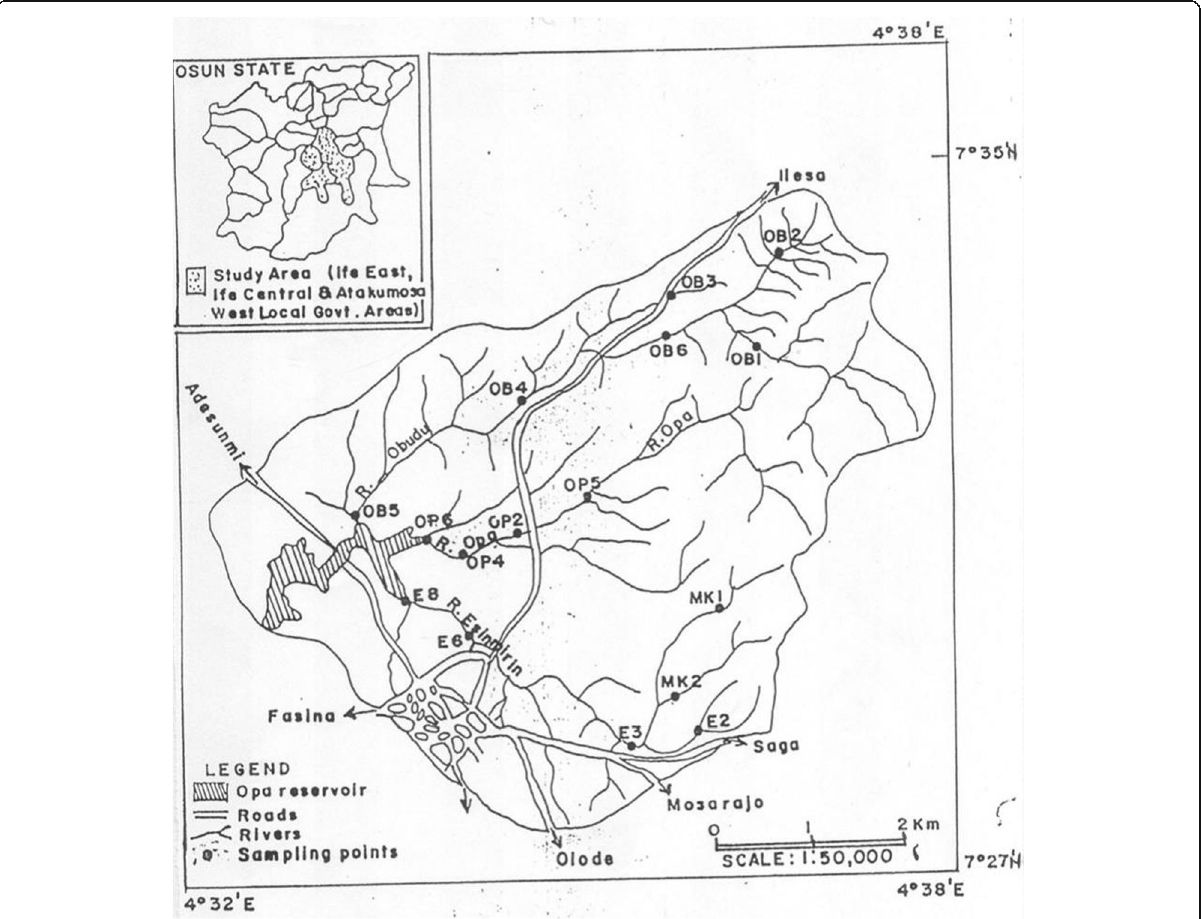
Fig. 1 Map of the study area and drainage basin of Opa Reservoir ’ s tributaries (inset: map of Osun State, Nigeria, showing the location of the study